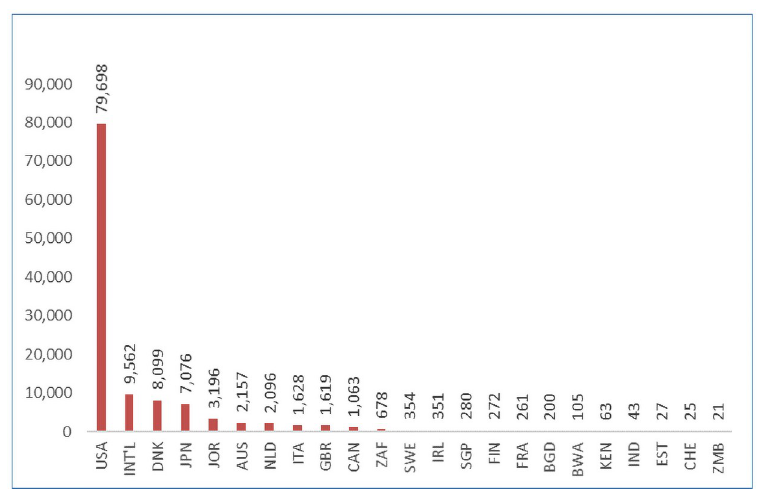
Fig 5. Number of participants by